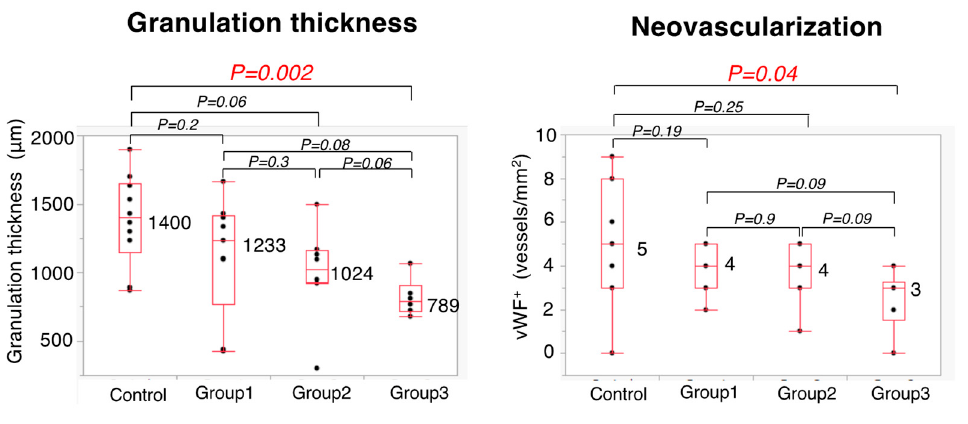
Figure 9. Histopathological assessment on POD 5.